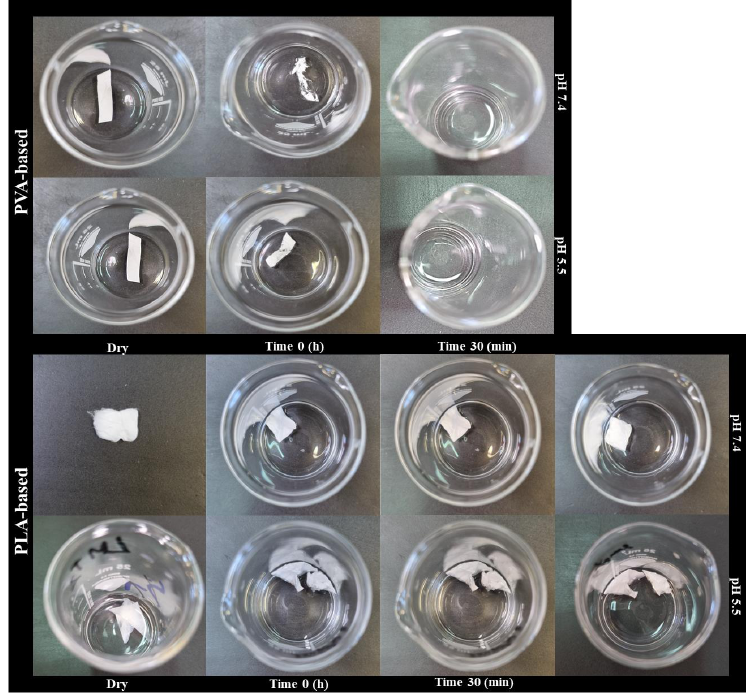
Figure 9. Images of the PVA (top) and PLA-based nanofibres (bottom) in the dry state, after addition of the medium (time 0), after 30 min and at the end of the experiment (24 h) at the two pH conditions tested (5.5 and 7.4).